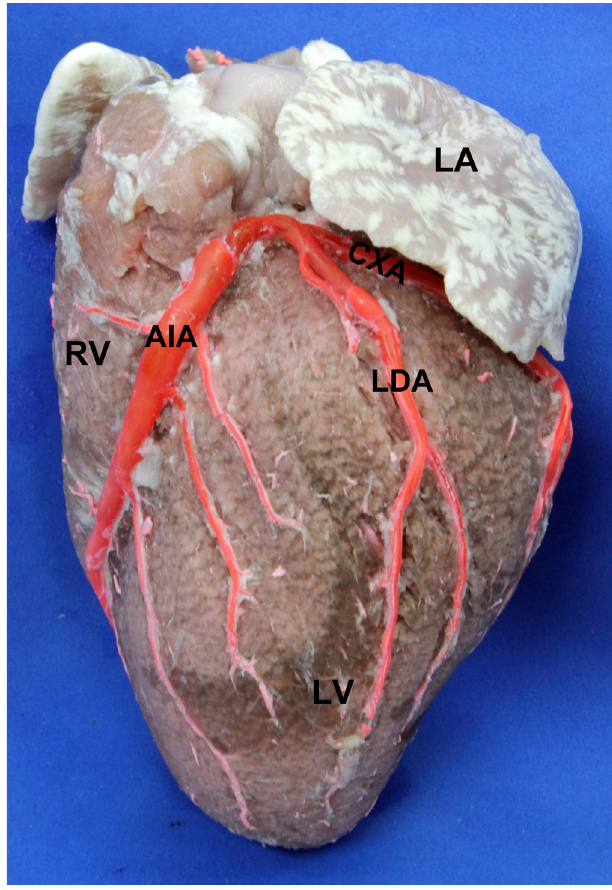
Fig. 1 - Obtuse edge of the heart.